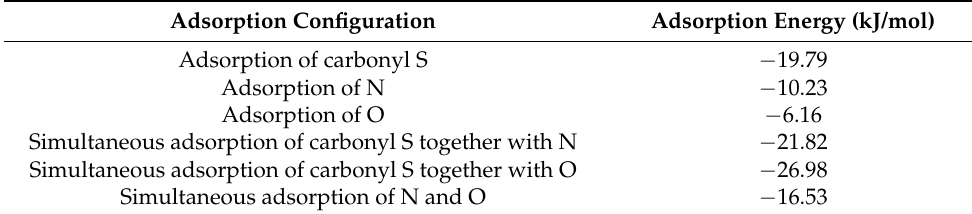
Table 11. Adsorption energy of each adsorption configuration of IPETC on each crystal plane.